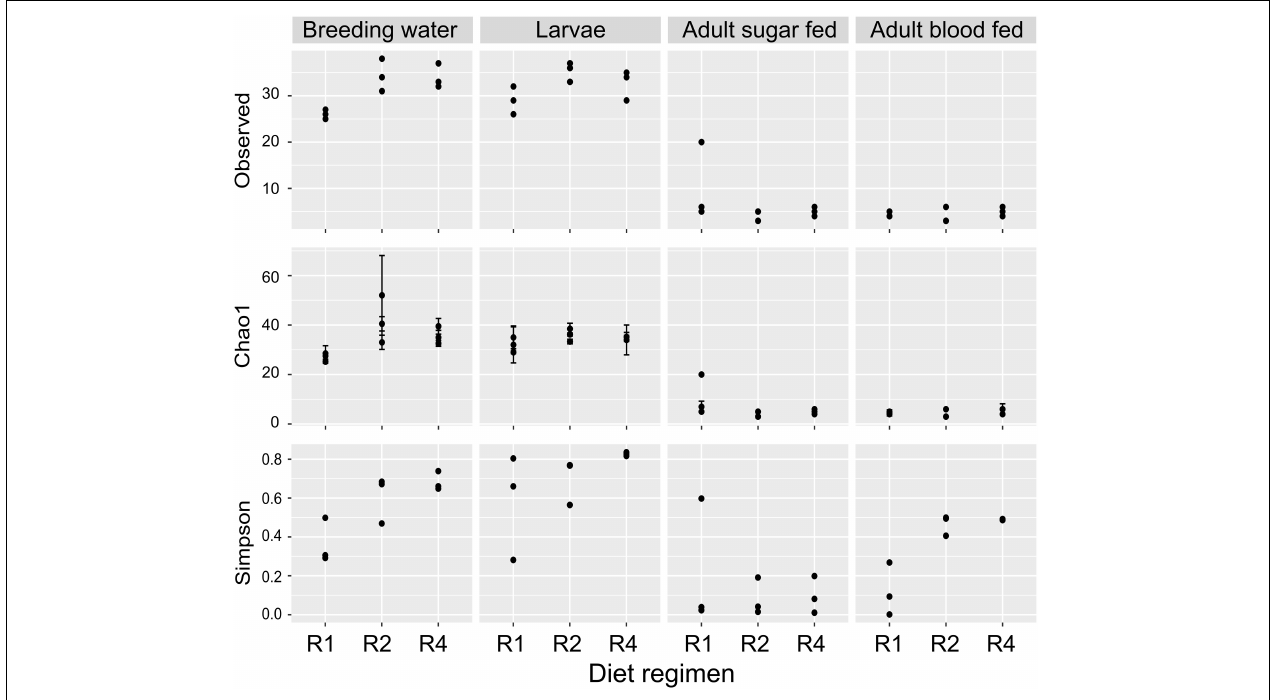
FIGURE 4 | Diet during larval breeding impacts alpha diversity. We measured alpha diversity across three larval diets (R1, R2, and R4) and four sample types (breeding water, larvae, adult sugar fed, adult blood fed). We performed a two-factor ANOVA including diet, sample type, and diet/sample type interaction as factors. For observed OTUs, the interaction of diet and sample type was not significant ( F = 2.193; p = 0.08), nor was the main effect of diet ( F = 0.296; p = 0.7459). Sample type, however, was significant ( F = 106.446; p = 4.38 × 10 − 16 ). For Chao1 values, the interaction of diet and sample type was significant ( F = 3.847, p = 0.008). For Simpson’s index (1-D), the interaction of diet and sample type was not significant ( F = 2.174; p = 0.08) but there was a significant effect of diet regimen ( F = 4.745, p = 0.016) and sample type ( F = 20.193; p = 2.35 × 10 − 7 ).